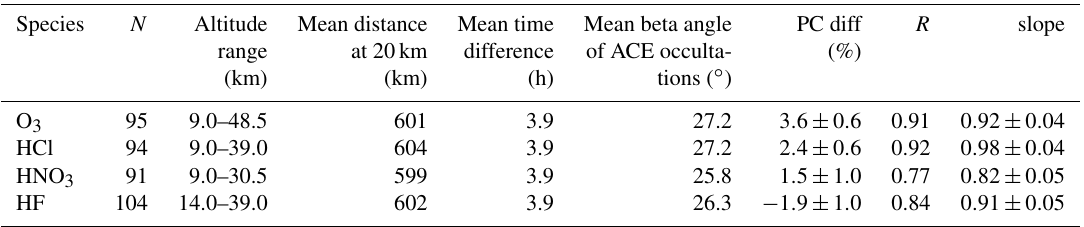
Table 5. Same as Table 4, but for the comparison of ACE-FTS v3.5 and the Bruker 125HR partial columns (2007–2013). Species N Altitude Mean distance Mean time Mean beta angle PC diff R slope range at 20km difference of ACE occulta- (%) (km) (km) (h) tions ( ◦ ) O 3